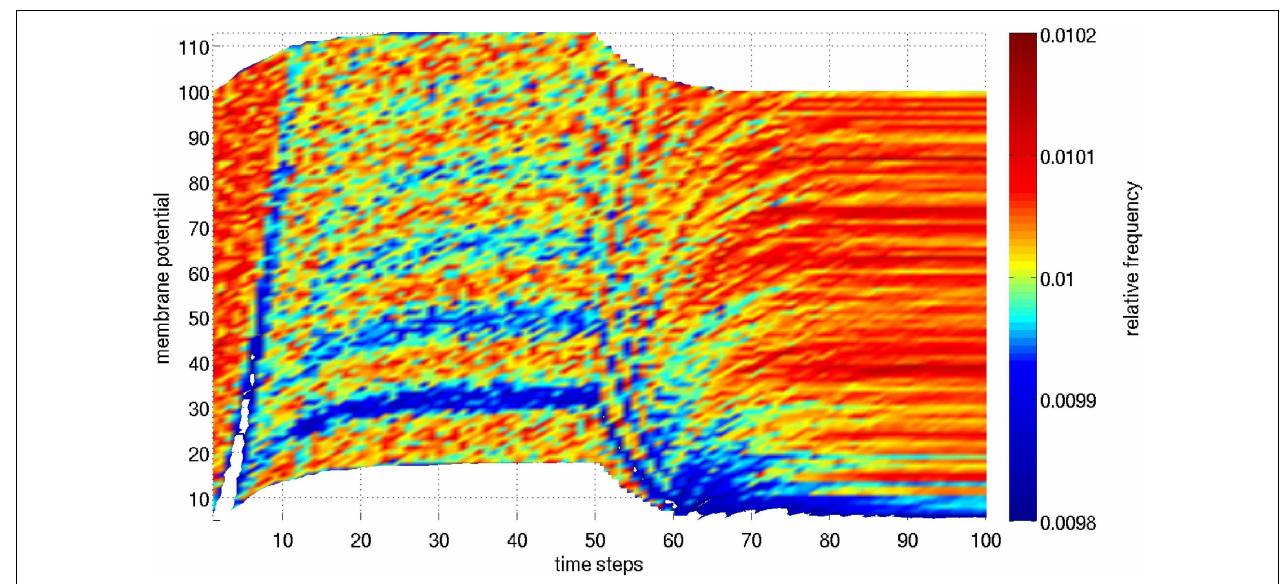
input, leaving a relative gap that is propagated upwards.Then, assemblies of neurons that are characterized by increased membrane potentials form when the recurrent input builds up. Finally, the system relaxes and the less regular spikes rebuild a more equally distributed picture until no further spikes are